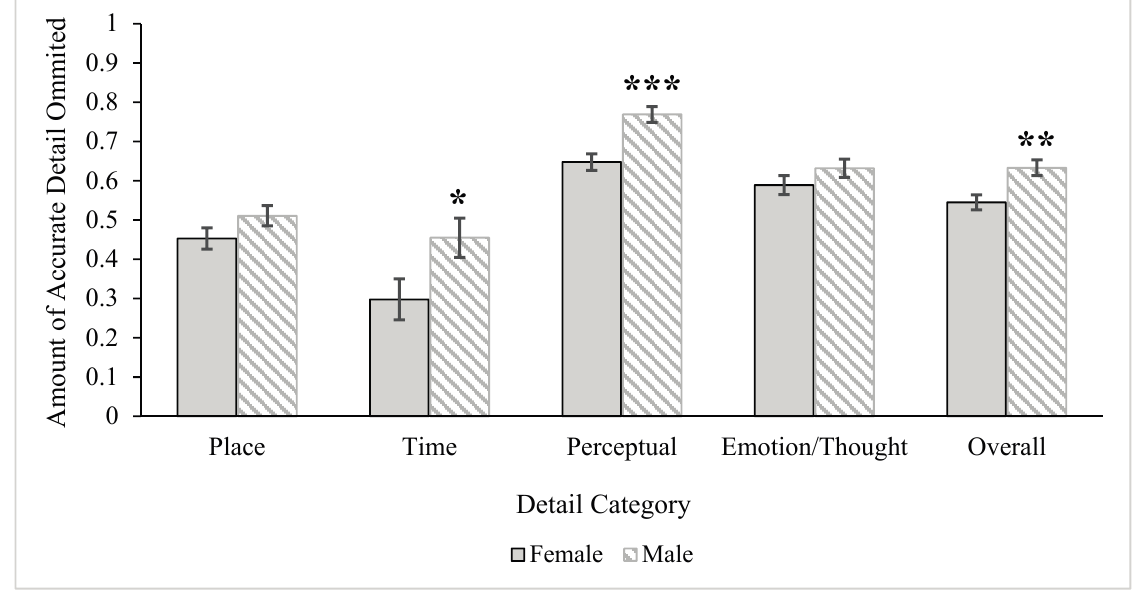
Figure 5. Gender differences in errors of detail omission overall and by category. Bars represent ± 1SE. Single asterisk marks significant effect at the p < 0.05 level, double asterisk marks significant effect at the p < 0.01 level, and triple asterisk marks significant effect at the p < 0.001 level. All effects remain significant except for the time gender difference